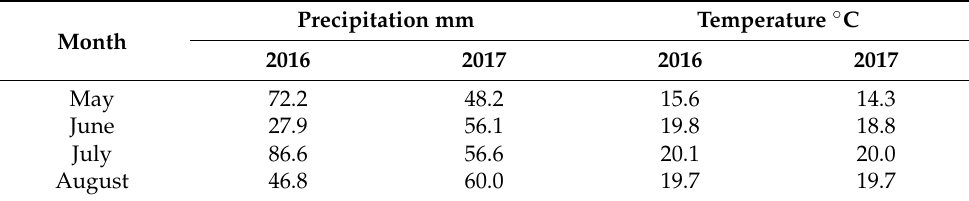
Table 4. Rainfall and temperature for the experimental site for the growing period (2016, 2017). Precipitation mm Temperature ◦ Month